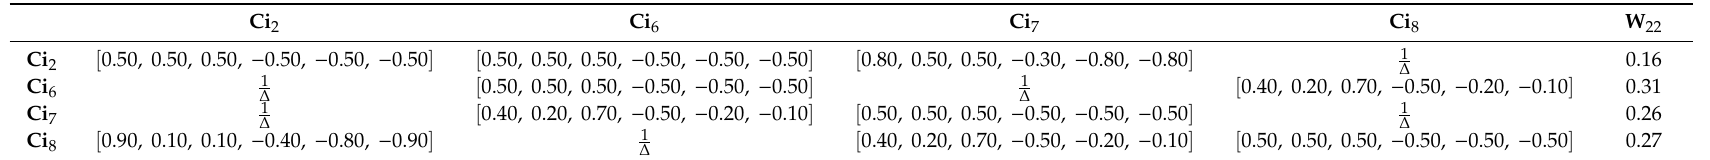
Table 8. Interior interdependencies matrix of factor C 3 .